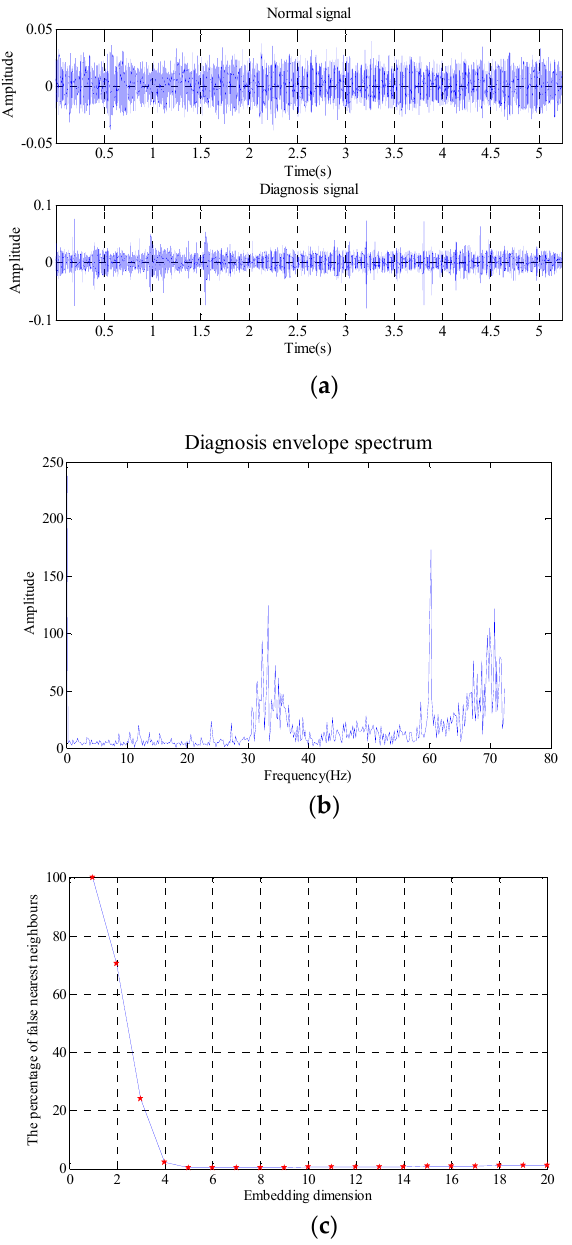
Figure 22. Inner race fault ( a ) time domain waveform; ( b ) envelope spectrum ( c ) embedded dimension.